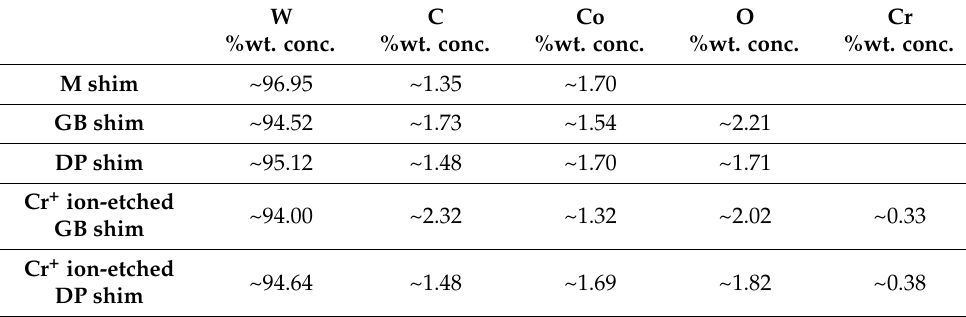
Table 5. EDS elemental composition of different pretreated shim surfaces. W %wt.